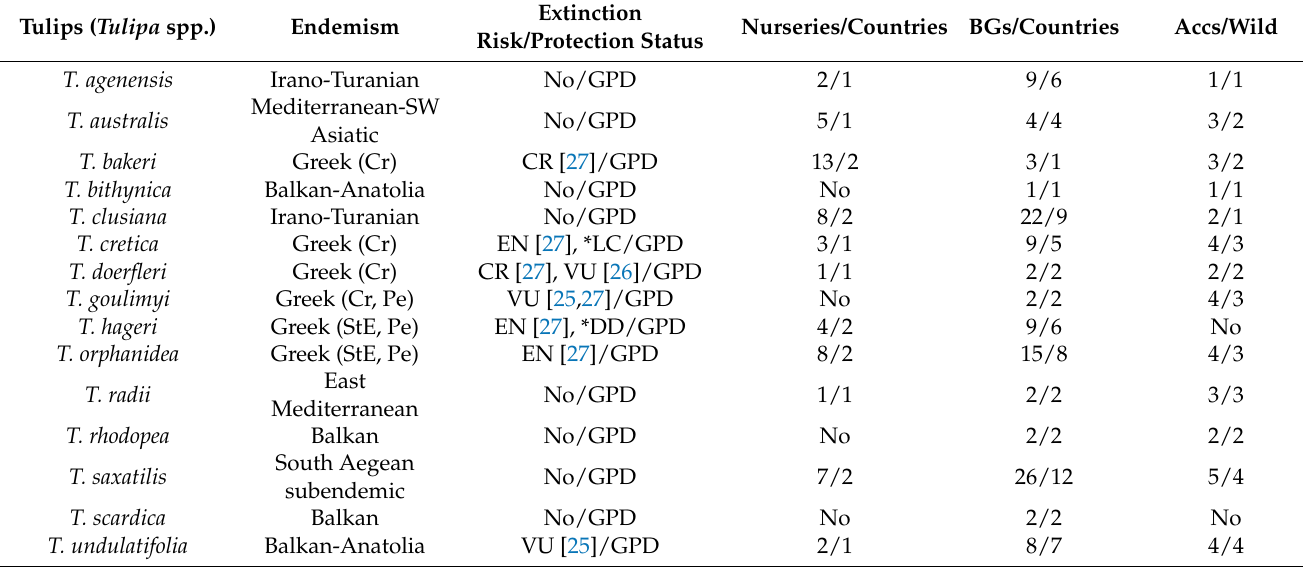
Table 1. Overview of the electronic trade and ex situ conservation of the 15 wild-growing Greek tulips (chorology, endemism, and protection status according to the official Vascular flora of Greece (http://portal.cybertaxonomy.org/flora-greece/ (accessed on 13 March 2021)) as well as species’ extinction risk assessments [25–27] and currently acquired accessions for their sustainable exploitation in the frame of the project TULIPS.GR. Tulips ( Tulipa